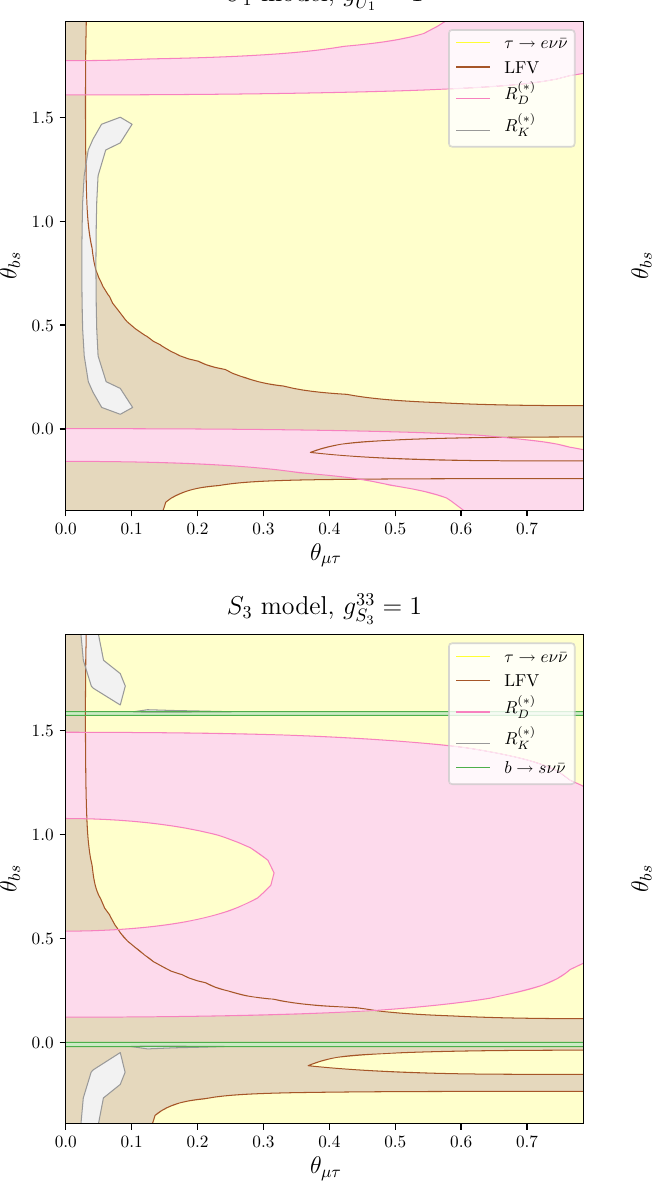
Fig. 1 The plots in the top row depict allowed new physics param- eter space, at 2 σ , due to various observables in the U 1 model. The left and right panels in the top row represent the allowed regions for = 1 and g 33 = 2 , respectively. The left and right panels in the g 33 U 1 U 1 bottomrowdepictstheallowedregionsinthe S 3 and U 3 models,respec-